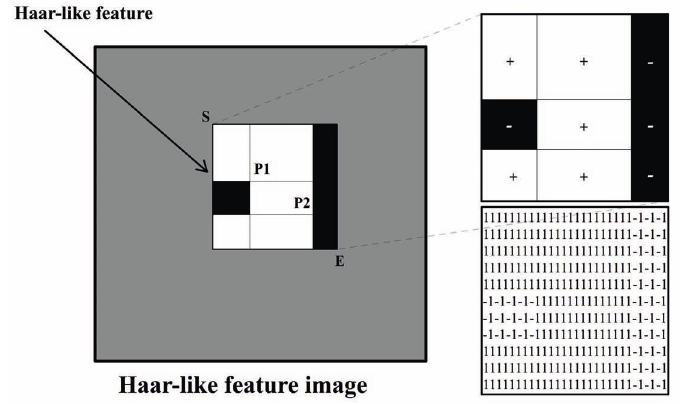
Figure 5. A Haar-like feature image with its Haar-like feature representation.